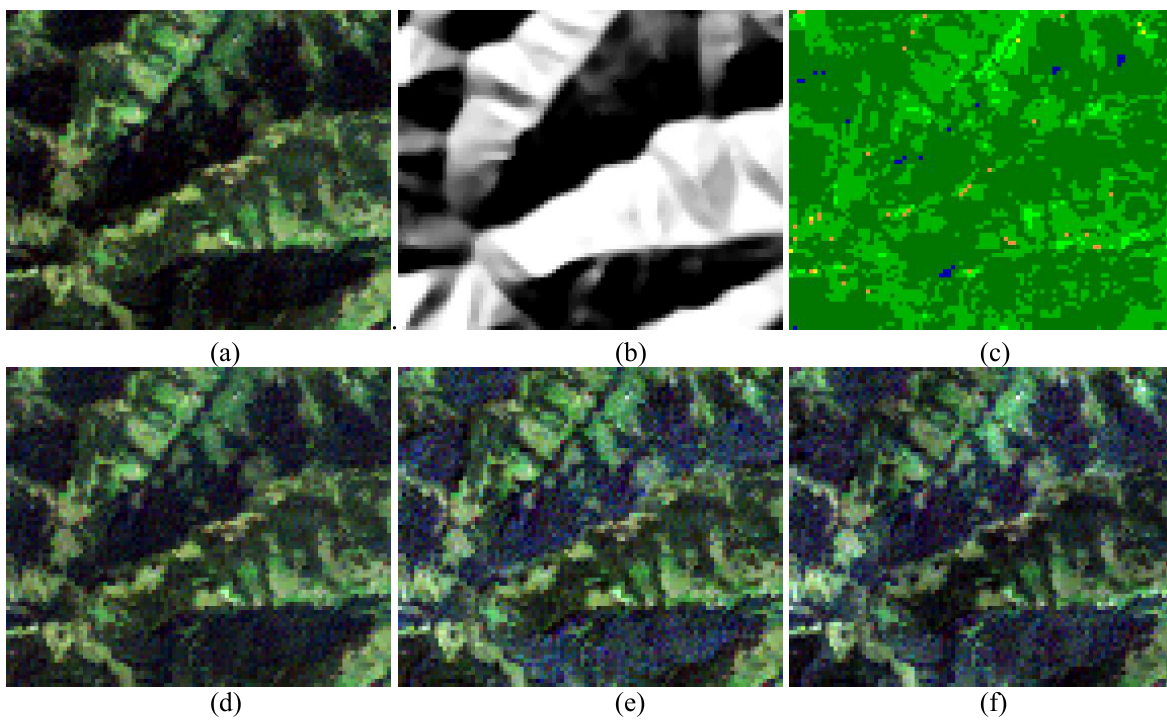
Figure 5b. Sub-scene 2 of (e), RGB = bands 7, 4, 5 (2200, 840, 1600 nm). (a) Original. (b) Illumination. (c) Classification. (d) C correction. (e) Gamma correction. (f) MM